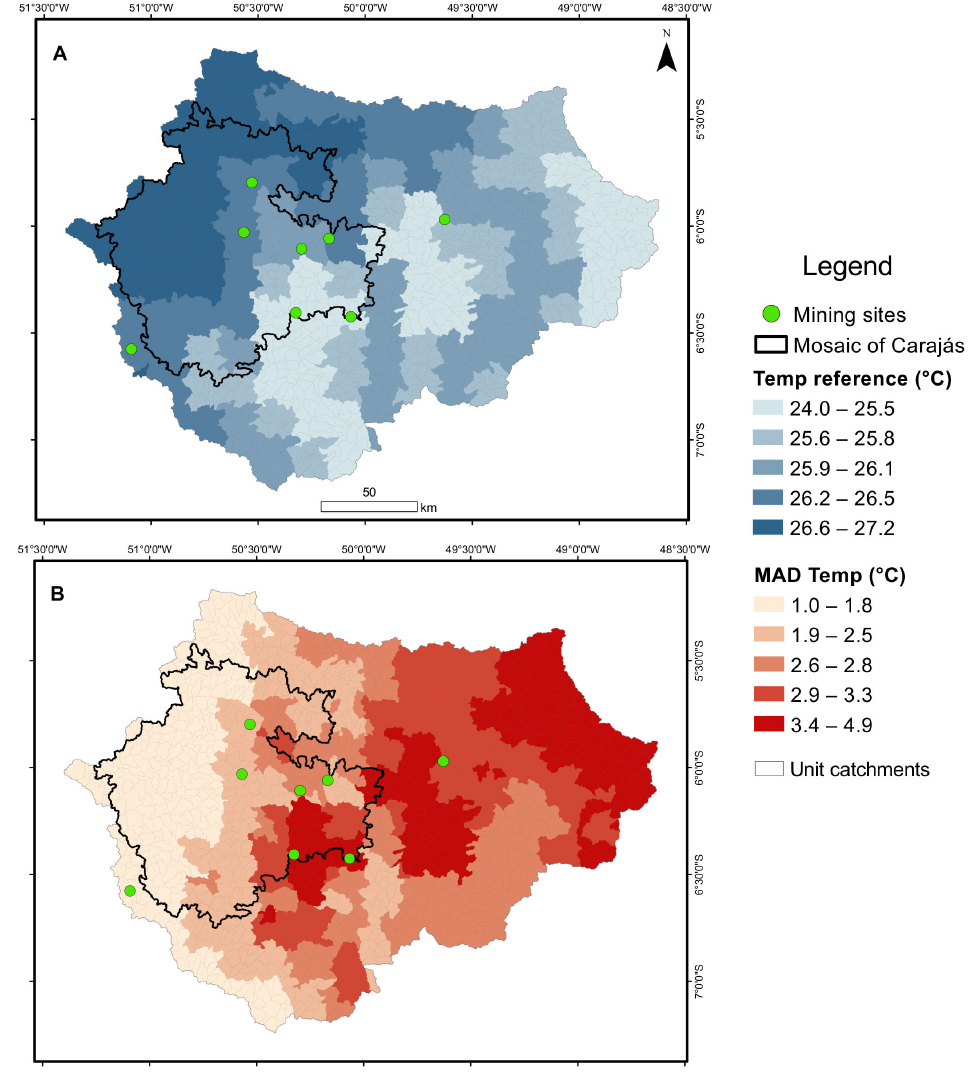
Figure 7. ( A ) Mean annual temperature Temp ( ◦ C) for the reference period, and (B ) mean absolute differences ( ◦ C) of mean annual temperature between the future (mGCMs) and reference periods for the RCP8.5 scenario (we decided not to show the results of RCP4.5 because the results showed similar spatial